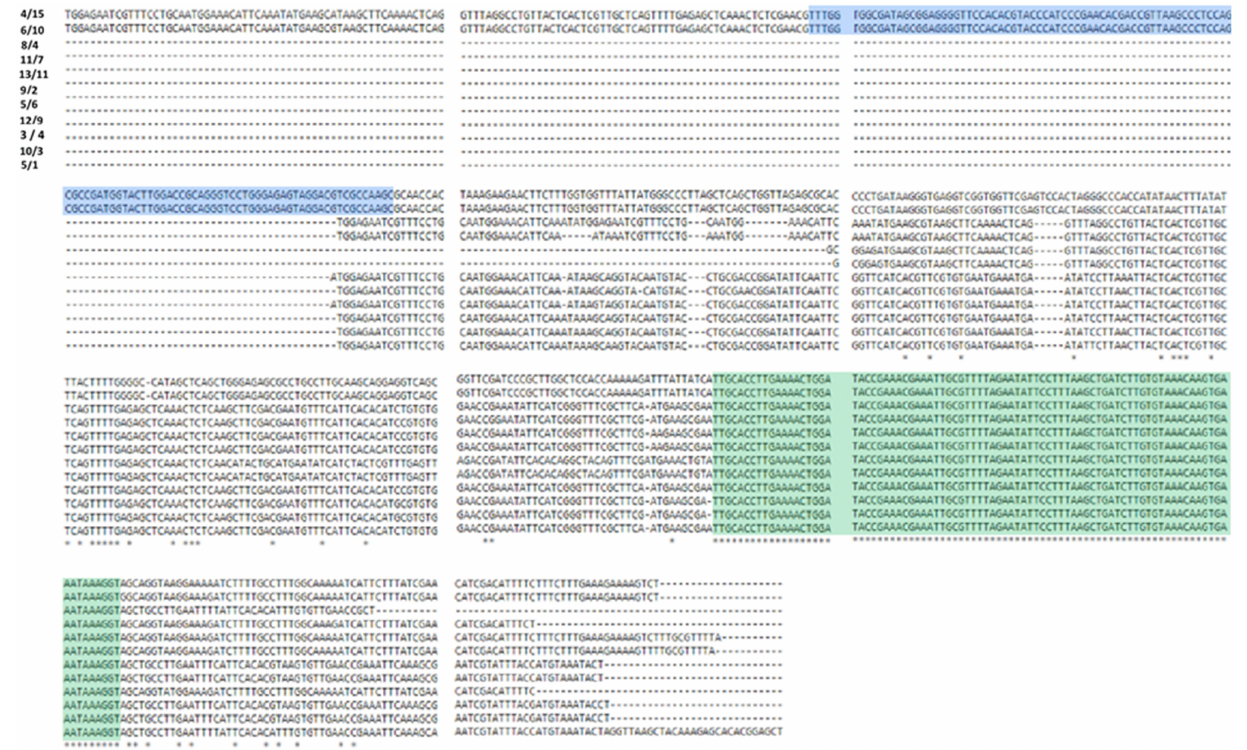
sequences were obtained using primers U2 and U3 and sequenced by Sanger sequencing and aligned by Clustal (cid:2) using default parameters. Sequence highlighted in blue corresponds to 5S ribosomal subunit DNA, highlighted in green represents a highly conserved P. polymyxa species-specific 89 nt sequence.